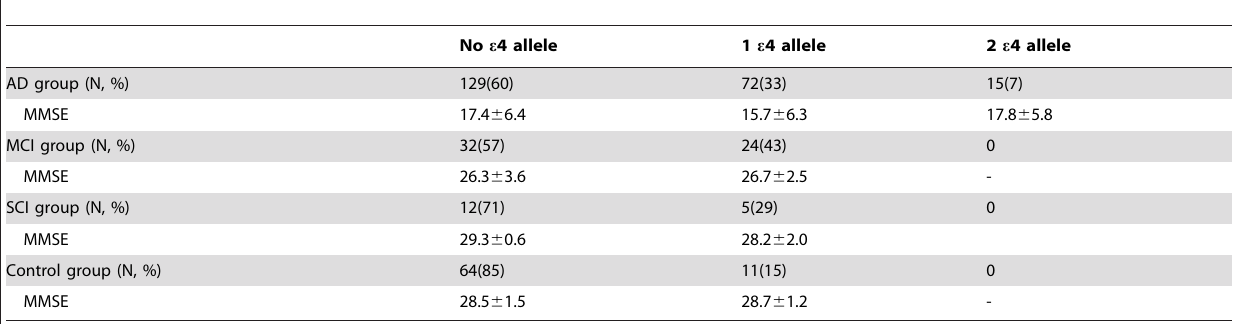
Table 4. MMSE score by number of APOE e 4 alleles in the four diagnostic